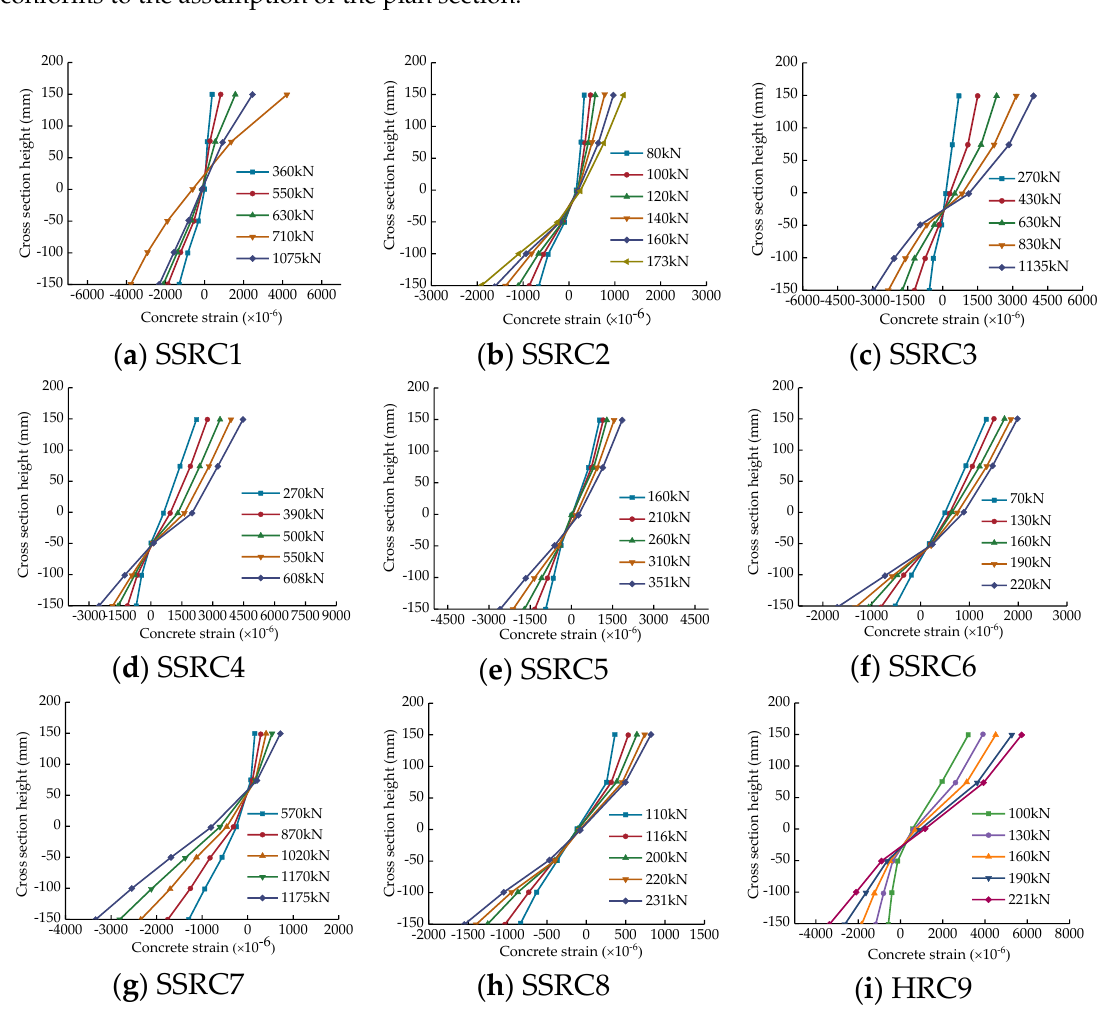
Figure 8. Concrete strain distribution at the midspan section.